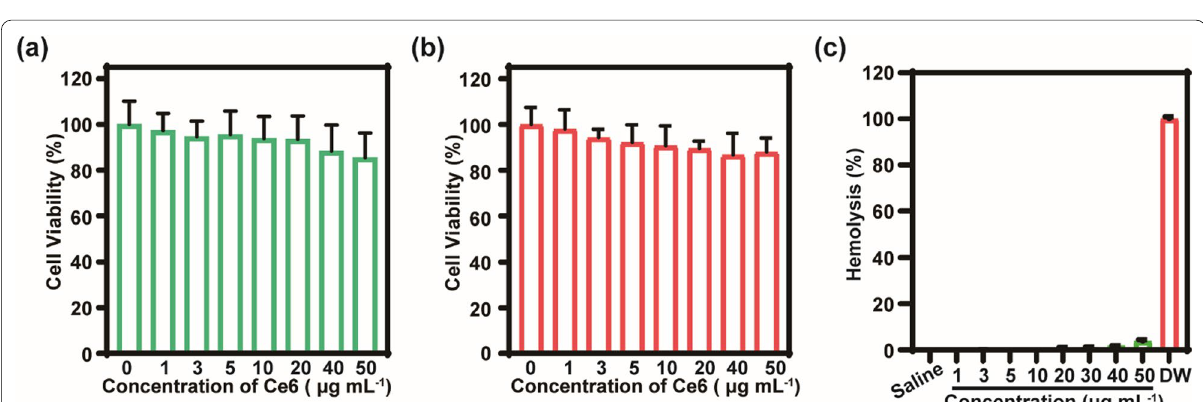
Fig. 4 In vitro biocompatibility of Ce6/Col/MM. The viability of Raw 264.7 ( a ) and L929 ( b ) cells treated with Ce6/Col/MM at various concentrations in dark for 24 h using MTT assay. c Hemolysis rate of RBC subjected to Ce6/Col/MM treatment at 37 °C for 1 h. Data are shown as mean